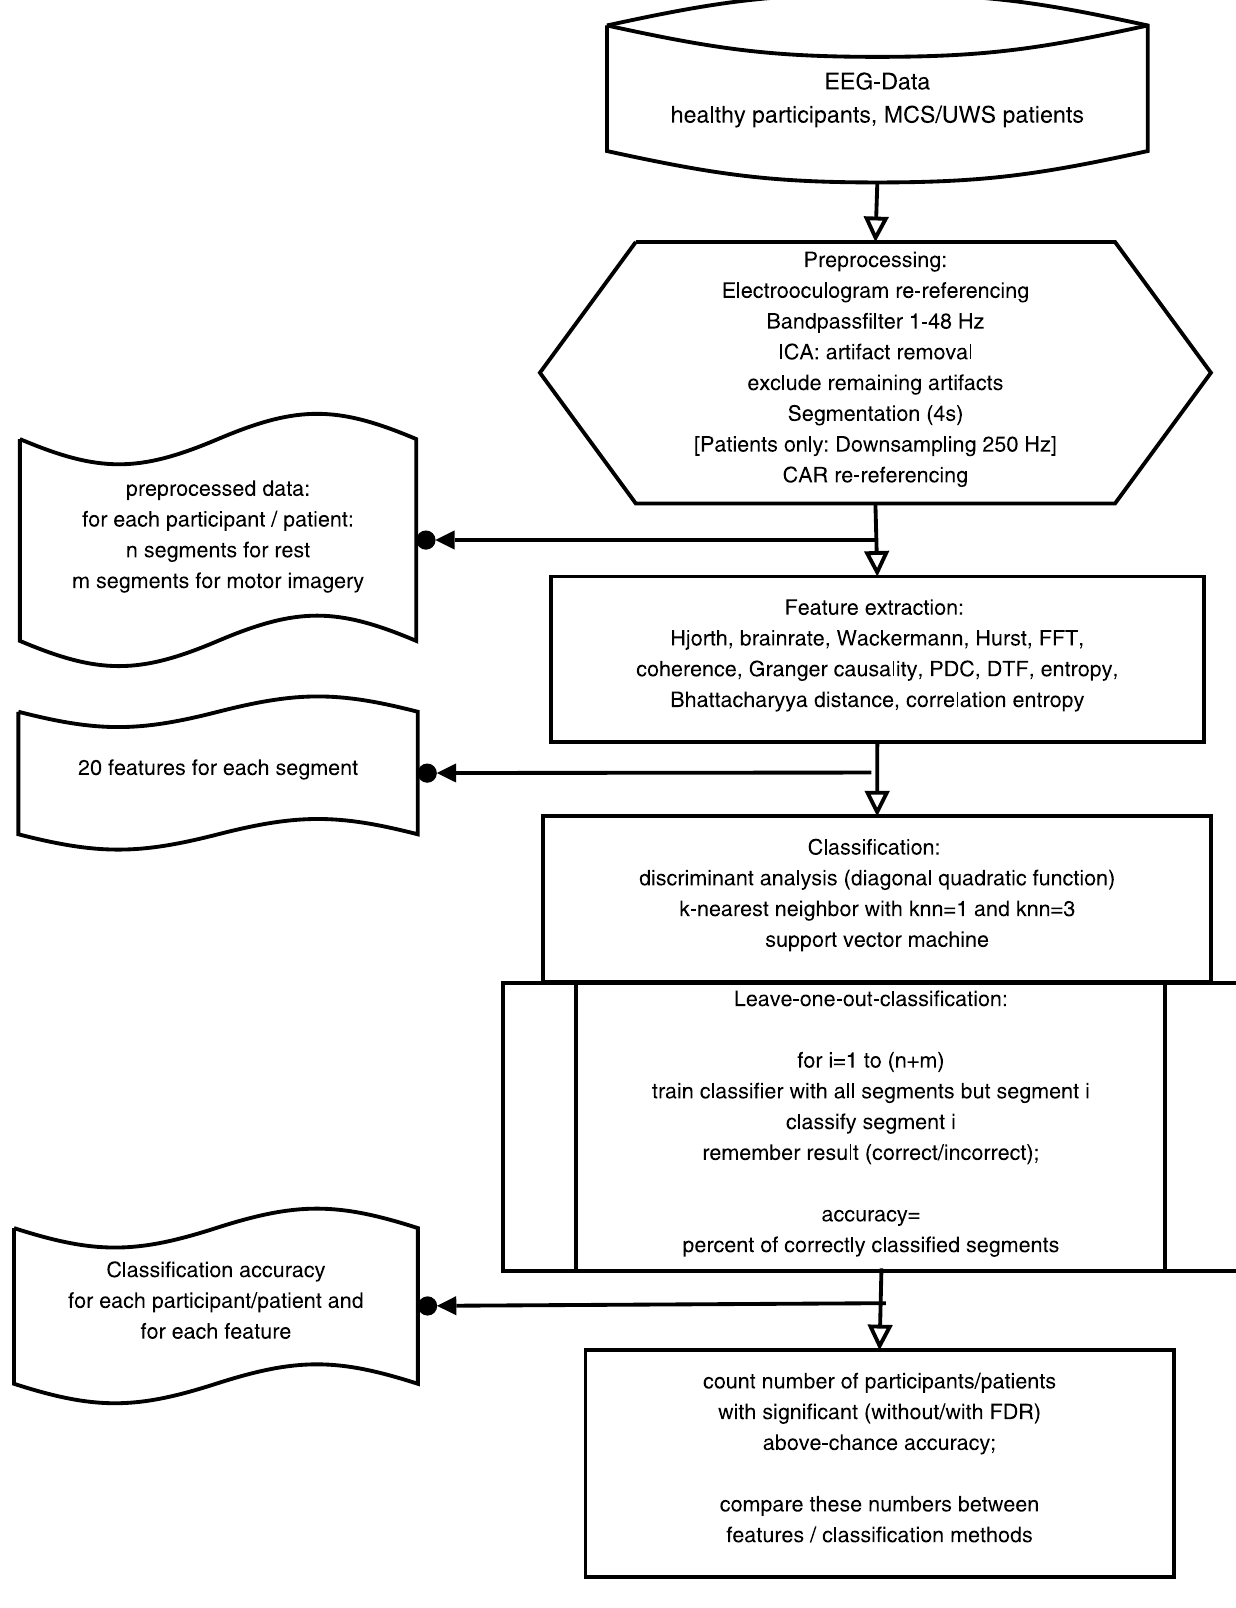
Figure 1. Procedure of data preprocessing, feature extraction, classification, and classification evaluation.